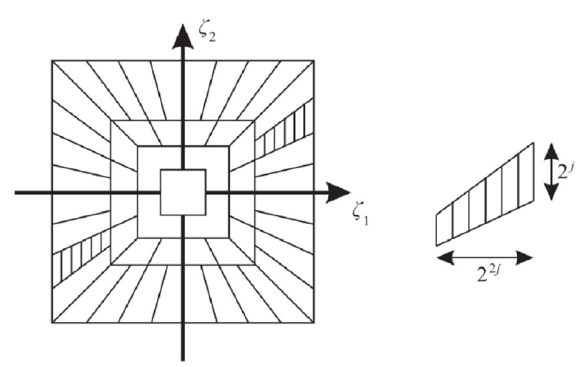
Figure 1. Frequency domain subdivision and its support interval .